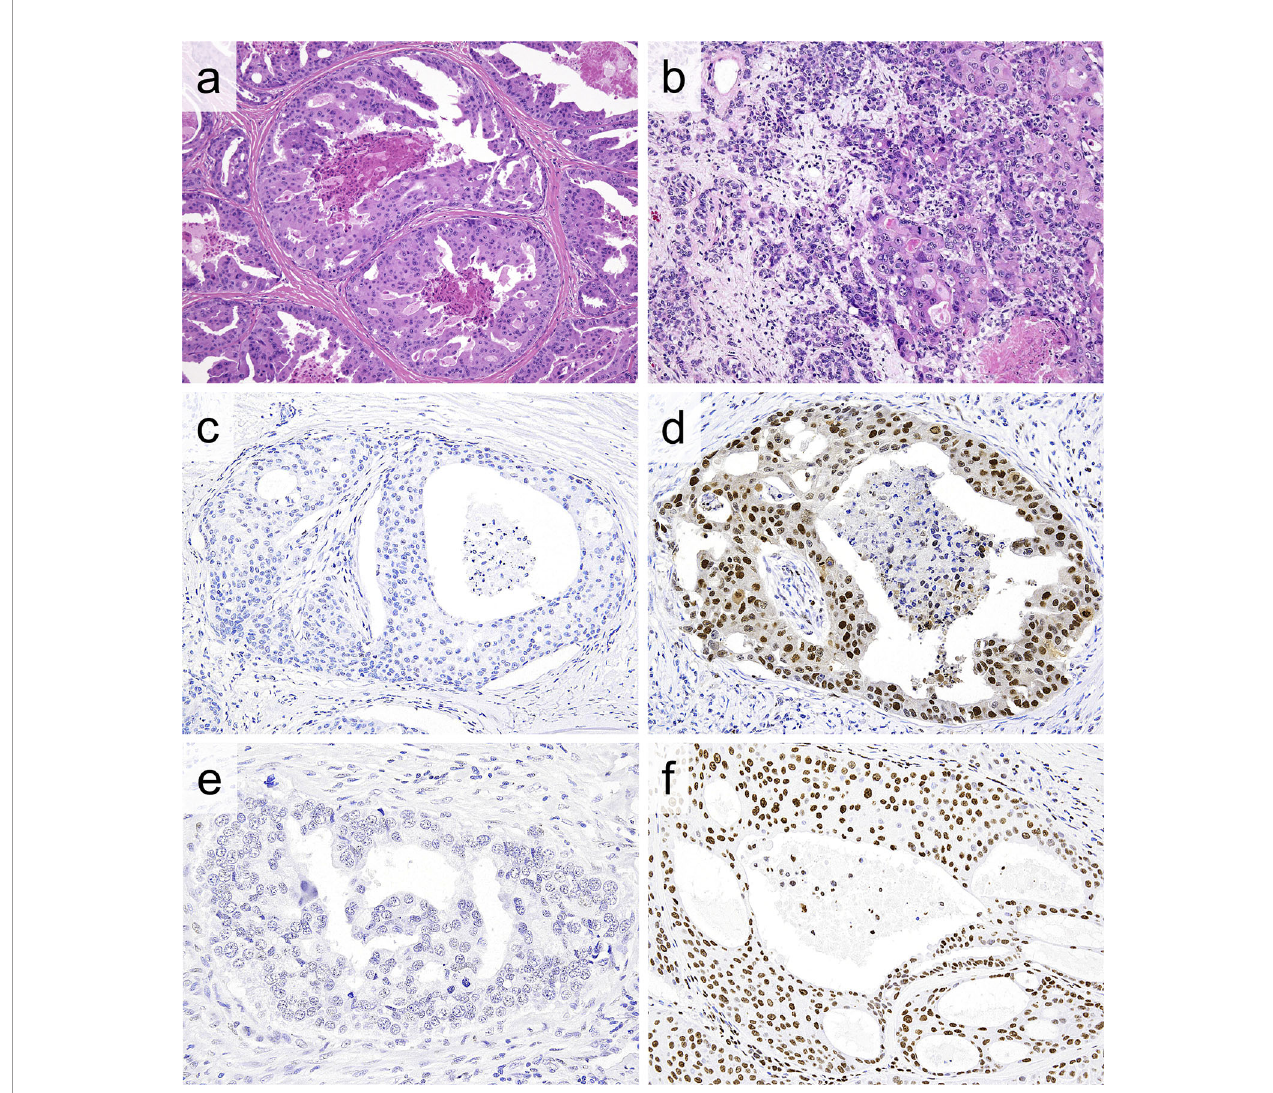
FIGURE 1 | (A, B) Representative histologic features of salivary duct carcinoma (SDC). (A) Dilated ductal structures with a papillary, “ Roman-bridge, ” or cribriform growth accompanied by comedo necrosis. (B) SDC ex pleomorphic adenoma composed of SDC (right portion) and a preexisting pleomorphic adenoma component (left portion). Note carcinoma cells exhibiting large pleomorphic nuclei and abundant eosinophilic cytoplasm. (C, D) Immunohistochemically, the EZH2 labelling index (LI) is low (0%) (C) and high (90%) (D) in SDC. (D) Diffuse and strong nuclear and weak cytoplasmic EZH2 immunoreactivity. (E, F) Likewise, the H3K27me3 LI is low (0%) (E) and high (90%) (F) in SDC. (F) Diffuse and strong nuclear H3K27me3